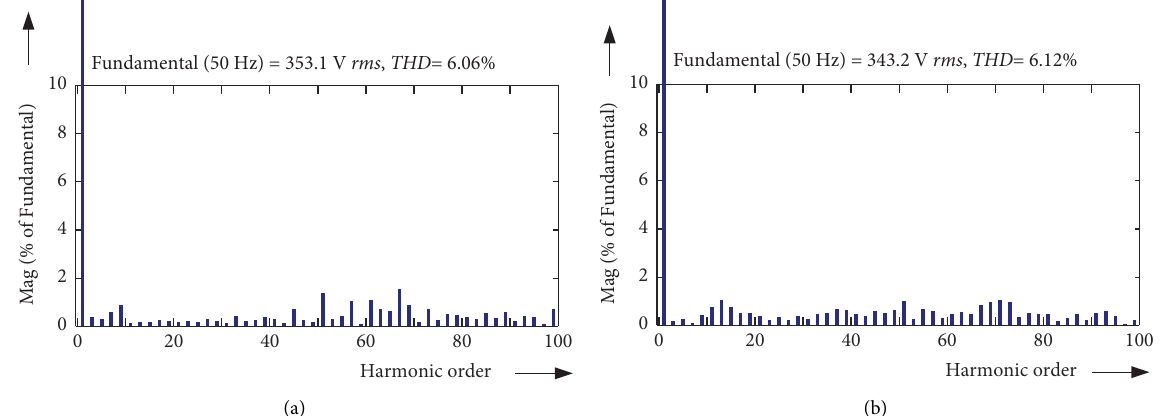
Figure 16: FFT spectra of line voltage at M � 1.0. (a) SVPWM-I. (b)